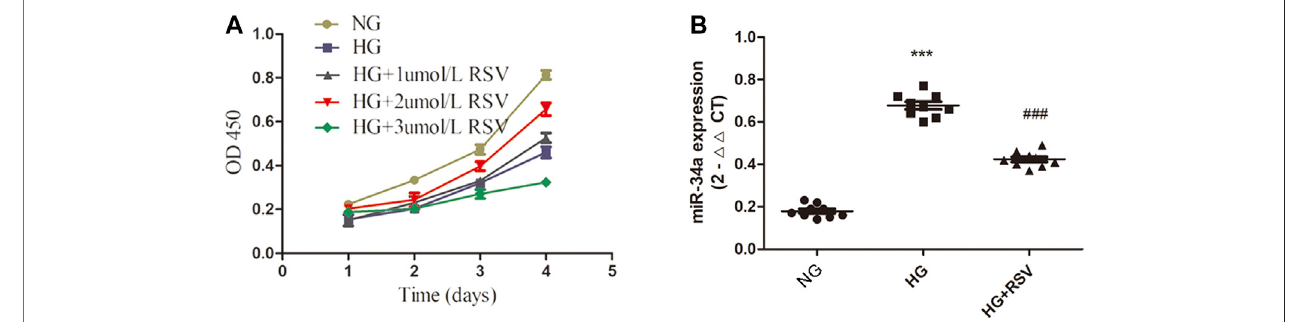
FIGURE2| RSVtreatmentincreasesBMSCsviabilityandreducesmiR-34aexpressionunderhyperglycemicconditions. (A) Theeffectsofdifferentconcentrations (1umol/L, 2umol/L, 3umol/L) of RSV pretreatment for different time on the activity of BMSCs. (B) qRT-PCR analysis was applied to detect the expression of miR-34a in